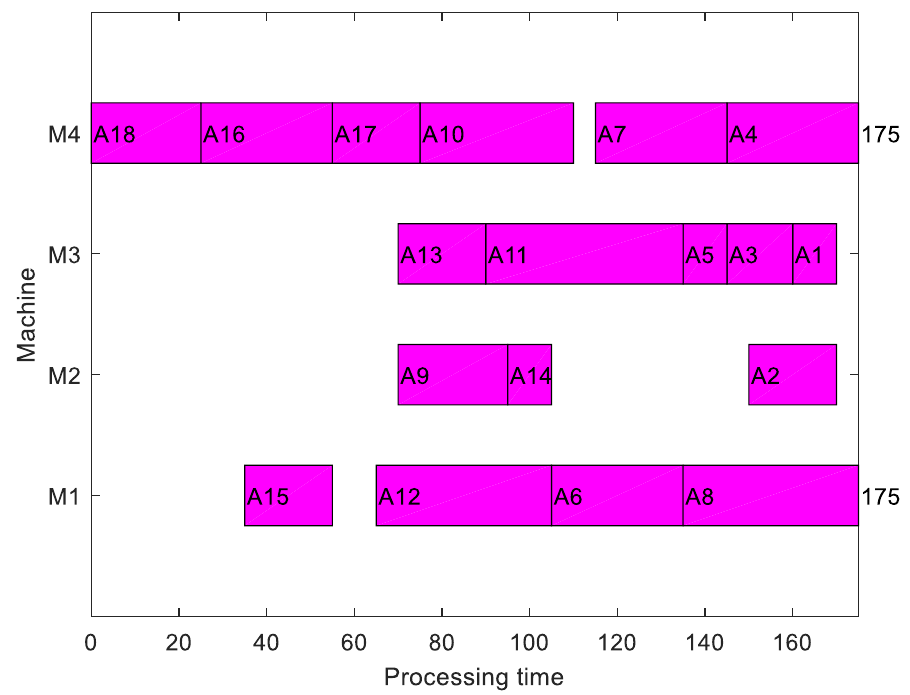
Figure 4. The inverse Gantt chart generated by decoding the individual shown in Figure 3.